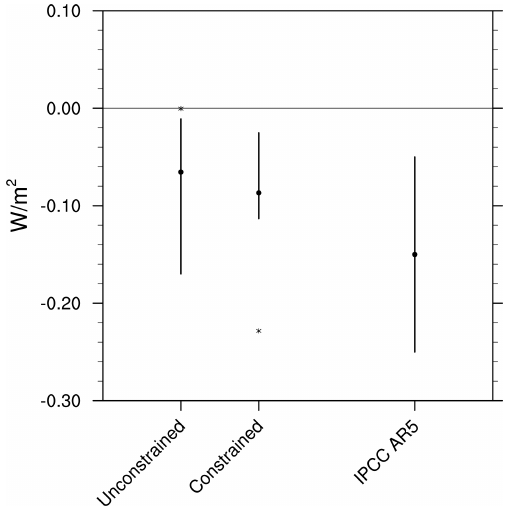
Figure 14. Spread in the unconstrained (left bar) and observation- constrained (middle bar) estimates of the global radiative forcing from historical conversions between trees and crops–grasses (from the pre-industrial to the 1981–2000 periods) for the CMIP5 models shown (Figs. 11 and 12; Wm − 2 ) and the IPCC AR5 estimate of the global radiative forcing from historical land use changes (mean estimate and spread as in Myhre et al., 2013). The dots on the left and middle bars show the model mean results for the unconstrained and observation-constrained estimates, respectively, and the aster- isks mark the results for the MIROC-ESM, while the lengths of the bars indicate the spread between the remaining values (i.e. exclud- ing